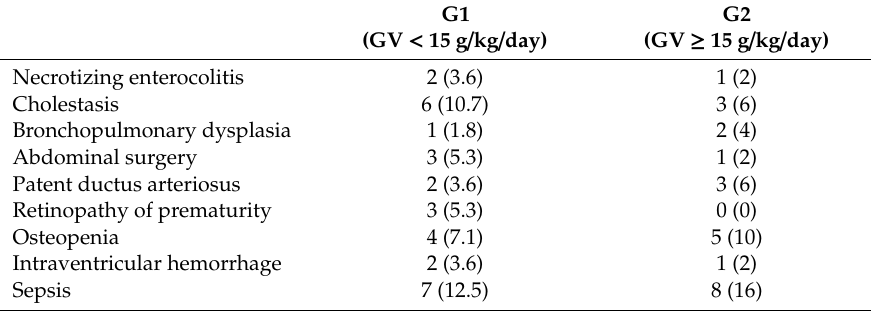
Table 2. Occurrence of comorbidities.